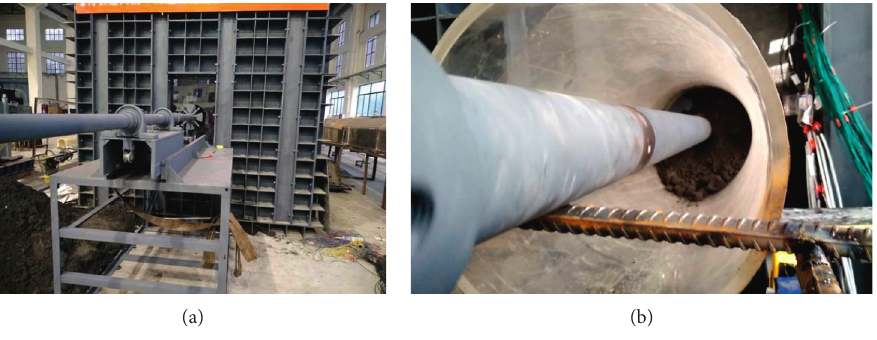
Figure 12: Shield tunnelling